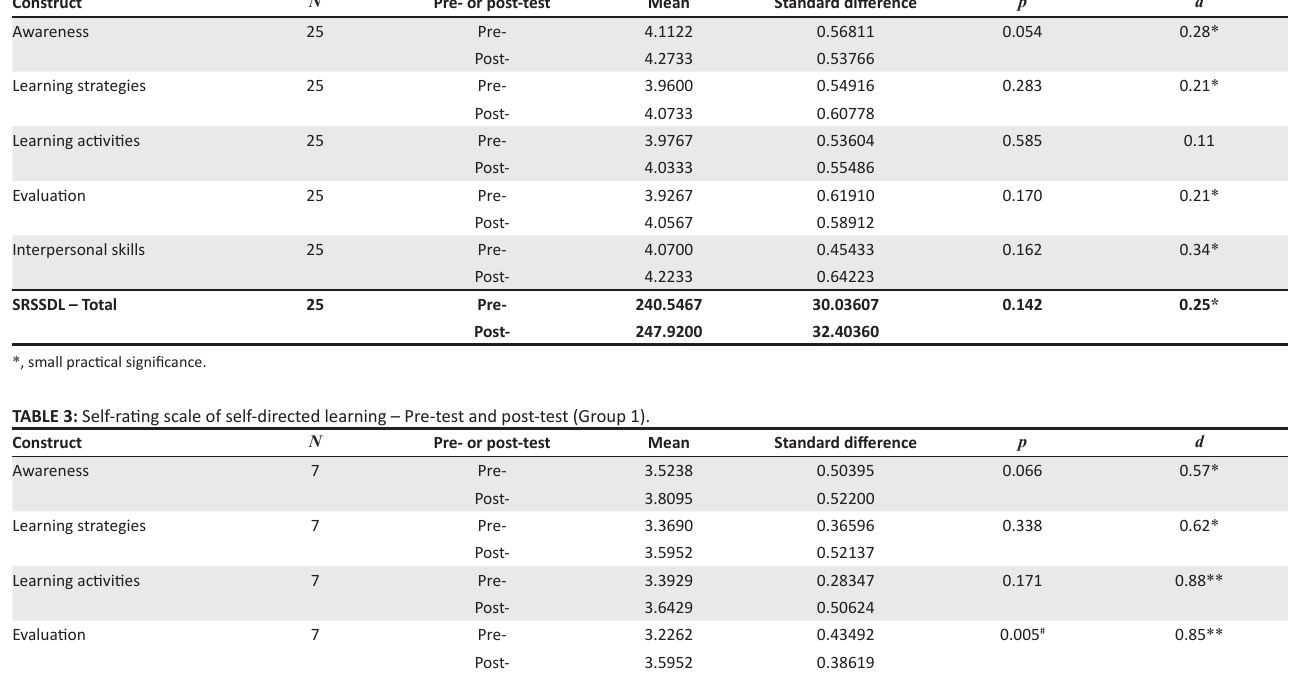
TABLE 2: Self-rating scale of self-directed learning – Pre-test and post-test. Construct N Pre- or post-test